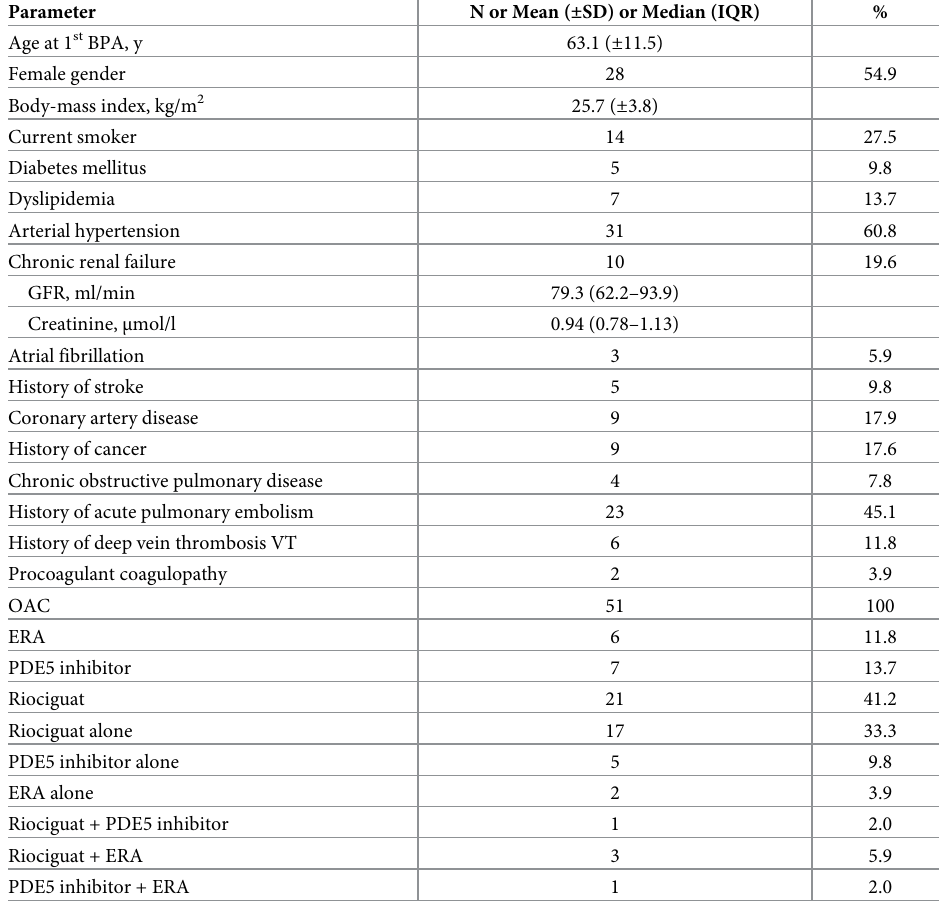
Abbreviations: BPA = Balloon pulmonary angioplasty, ERA = endothelin receptor antagonist, GFR = glomerular filtration rate, OAC = oral anticoagulative therapy, PDE5 = phosphodiesterase type 5;